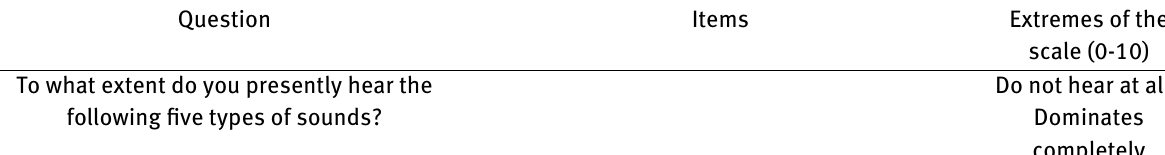
Table 1: The Sound Walk Questionnaire. For each question, participants could express their preference on a ten-point ordinal